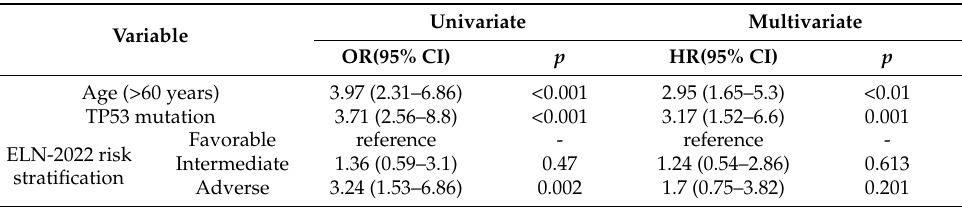
Table 3. Univariate and multivariate analysis for overall survival.